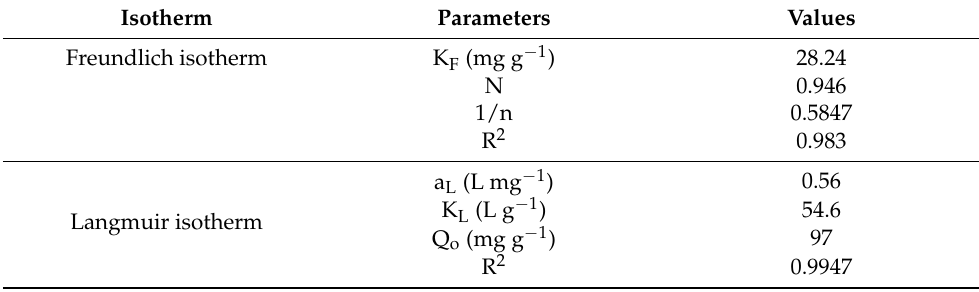
Table 4. Freundlich and Langmuir isotherm constants for MY adsorption on CPSMNPs.